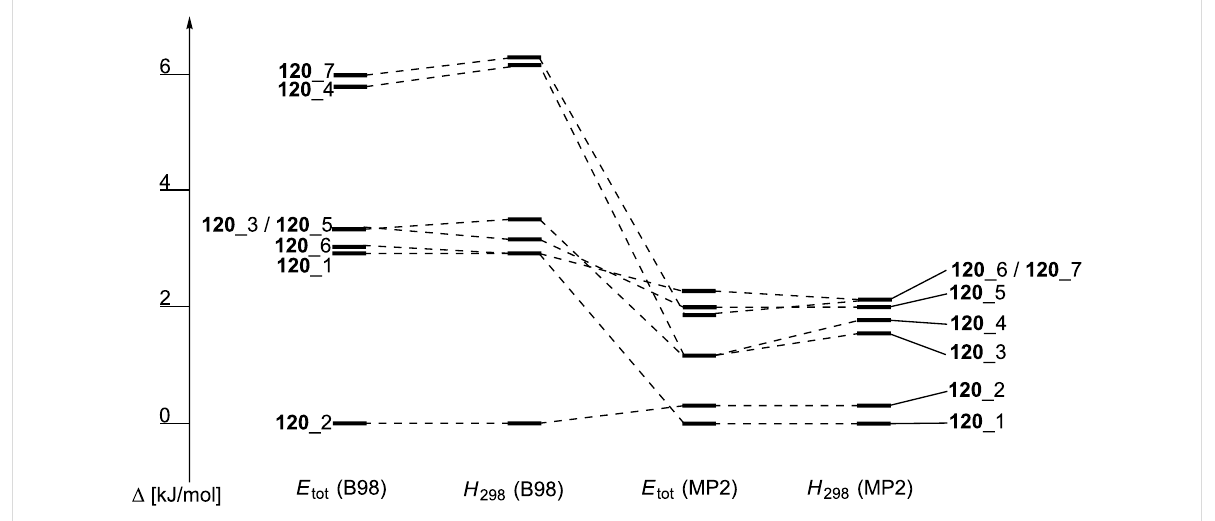
Figure 15: Relative order of the conformations 120 _1 to 120 _7 depending on the level of theory.